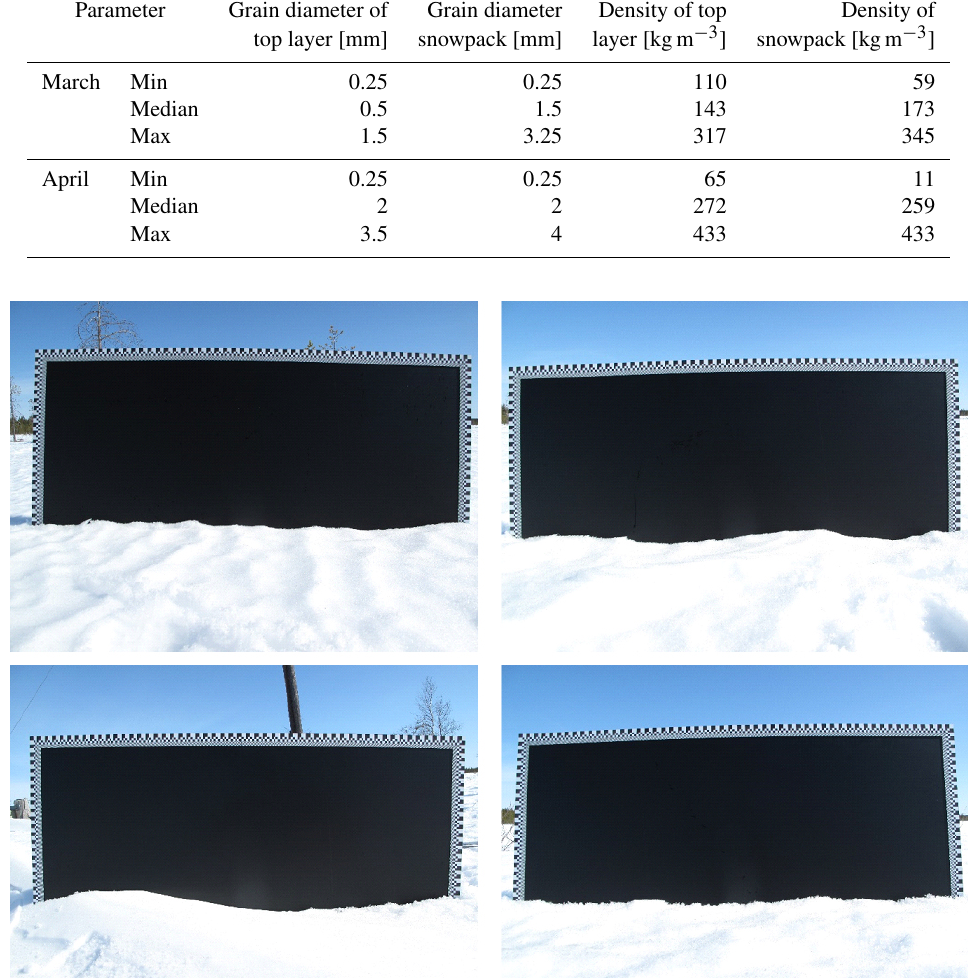
Kaasalainen et al. (2011) to be better than 5 cm, while